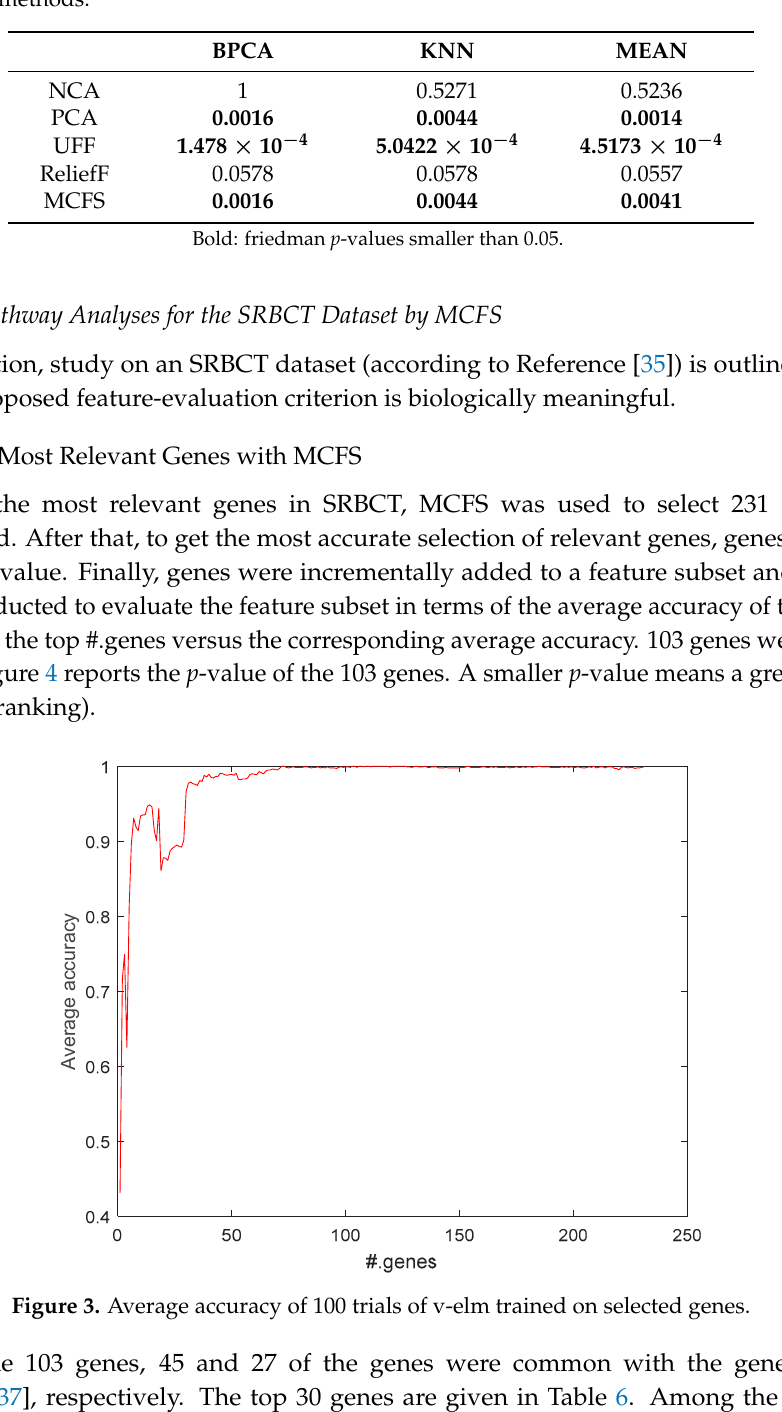
Figure 2. Comparison of balanced accuracies with three imputation methods, respectively.